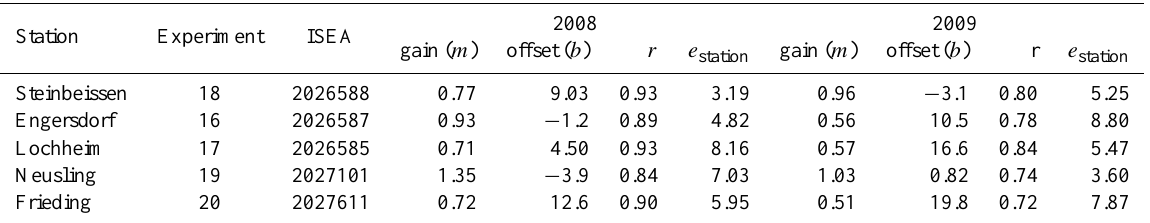
Table 2. Linear regression parameters (gain, offset, correlation coefficient r ) between the soil moisture time series of a station as compared against the corresponding spatial average.